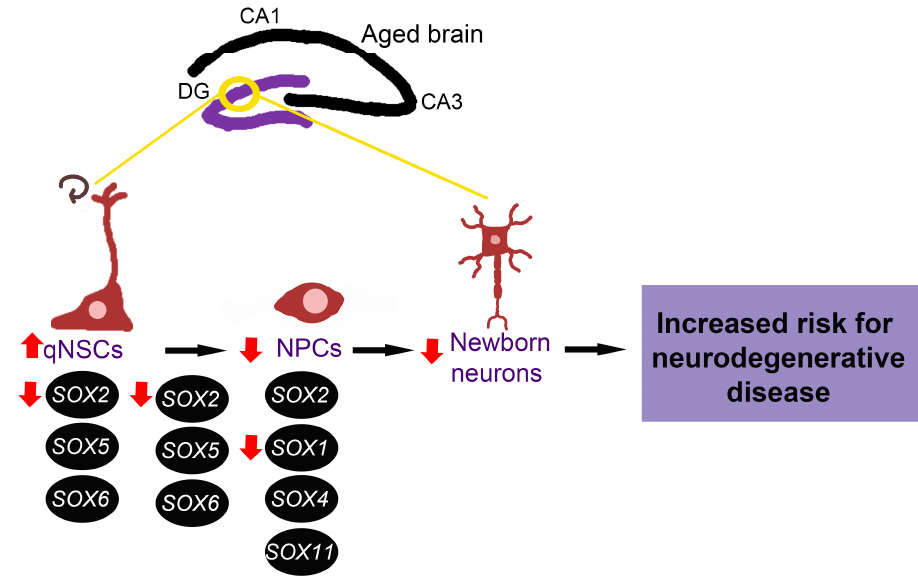
Figure 4. Possible involvement of SOX genes in impaired adult neurogenesis during ageing. Alternations of adult neurogenesis that are detected with ageing, increased quiescence of NSCs and lengthened cell cycle of NPCs, could be directly correlated with decreased SOX1 and SOX2 expression detected in the hippocampus during ageing. The expression and function of SOX4, SOX5, SOX6, SOX11 in ageing brain (hippocampus) are yet to be revealed. qNSCs—quiescent neural stem cells, NPCs—neural progenitor cells, DG—dentate gyrus, CA1—cornu ammonis 1, CA3—cornu ammonis 3. The scheme is based on the previously reported publications [16,19,22,23,89].